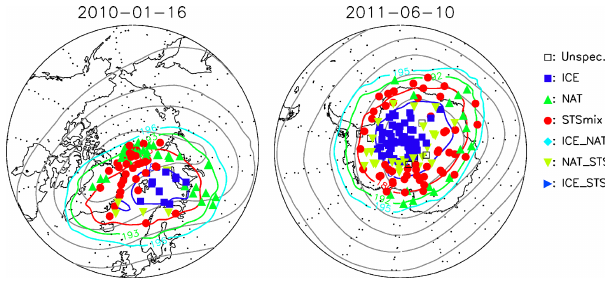
Figure 2. Examples of the horizontal distributions of MIPAS PSC composition classes for NH winter and SH winter conditions at an altitude level of 500K potential temperature ( ± 20K). In addition to the different cloud-type symbols described in the figure legend (see main text for details), temperature contours for T ICE (dark blue) (Marti and Mauersberger, 1993), T STS = (T NAT + T ICE )/ 2 (red), T NAT (green) (Hanson and Mauersberger, 1988), and T NAT + 2K (turquoise) based on ERA-Interim data (Dee et al., 2011) with con- stant water vapour and nitric acid mixing ratios, grey contours of the Montgomery stream function at 500K, and black dots for non- cloudy MIPAS profile locations are